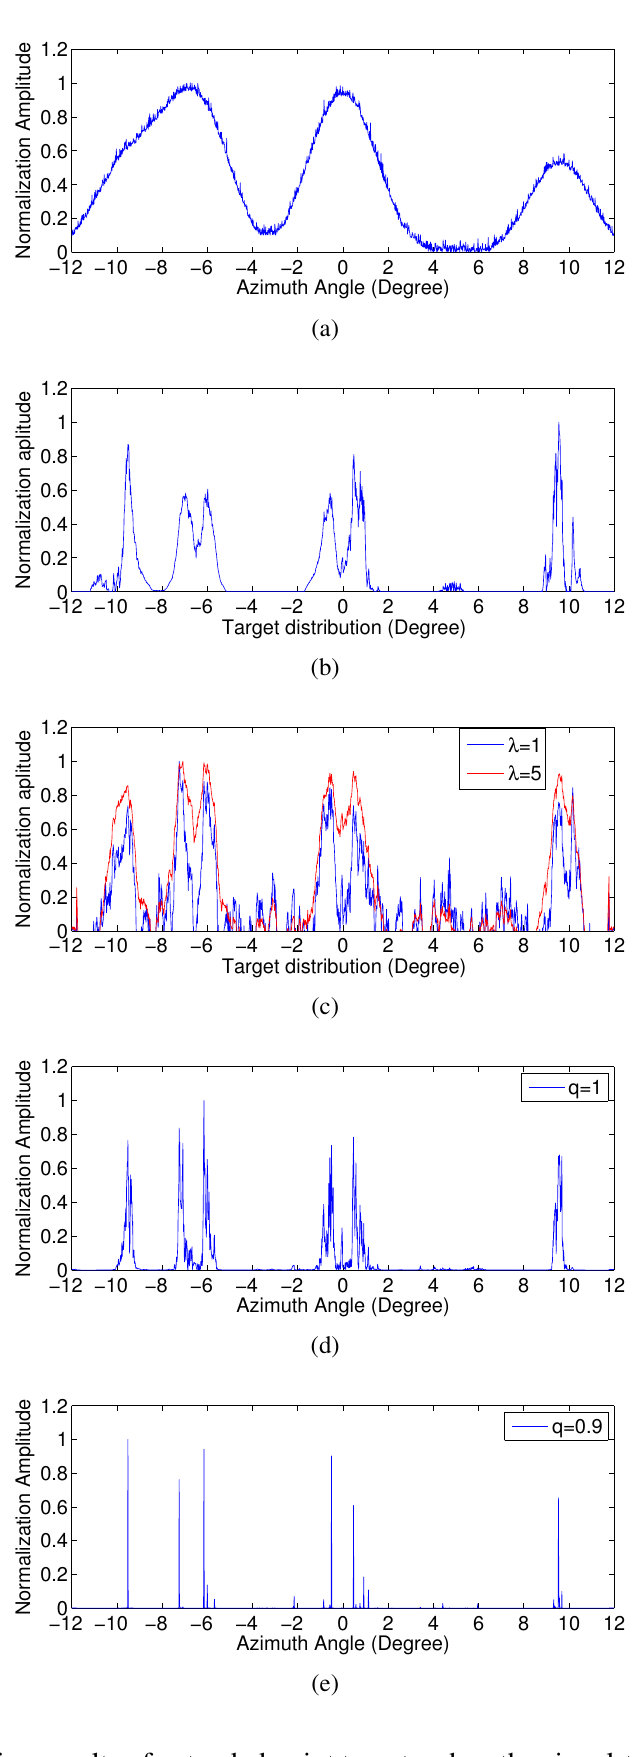
Figure 3. Simulation results of extended point targets when the signal-to-clutter ratio (SCR) is 25 dB. ( a ) Real aperture signal. ( b ) Richardson-Lucy (RL) algorithm. ( c ) Tikhonov regularization with different regularization parameters. ( d ) Proposed algorithm when q = 1 . ( e ) Proposed algorithm when q = 0 . 9